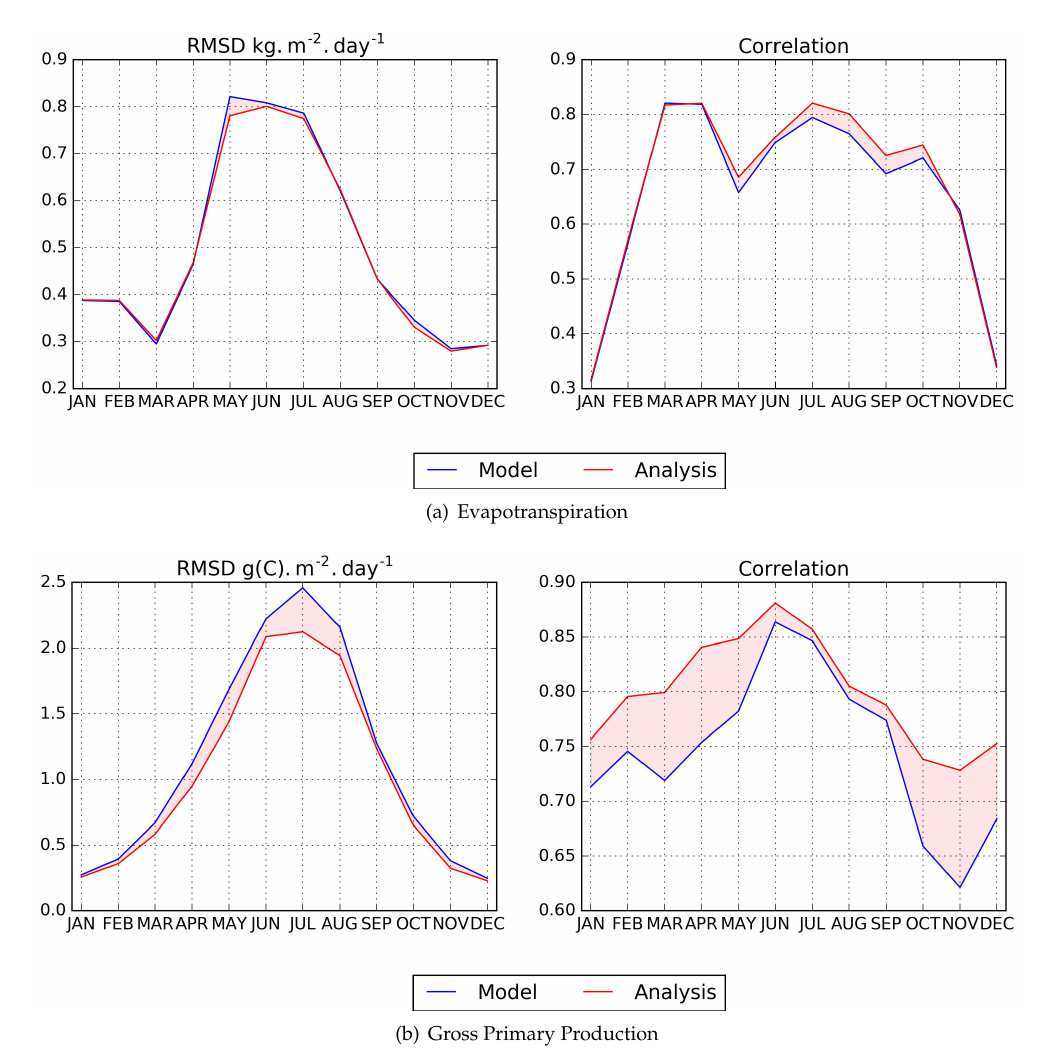
Figure 5. Monthly seasonal scores (RMSD and correlation) of the open-loop (blue) and analysis (red) simulations from 2007–2015 averaged over the Euro-Mediterranean area compared to the products of: ( a ) GLEAM Evapotranspiration (E) and ( b ) FLUXNET-MTE gross primary production (only 2007–2011). Red shade indicates an improvement from the assimilation process with either a lower error or a higher correlation